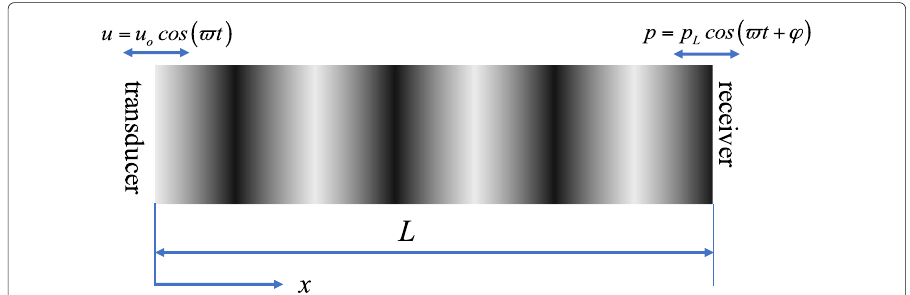
Fig. 11 Schematic of the sound propagation between transducer and receiver. The sound is generated by the periodic oscillation of the transducer, while the receiver measures the pressure amplitude and the phase shift. The dimensions perpendicular to the x -direction are much bigger than L , so that the problem is